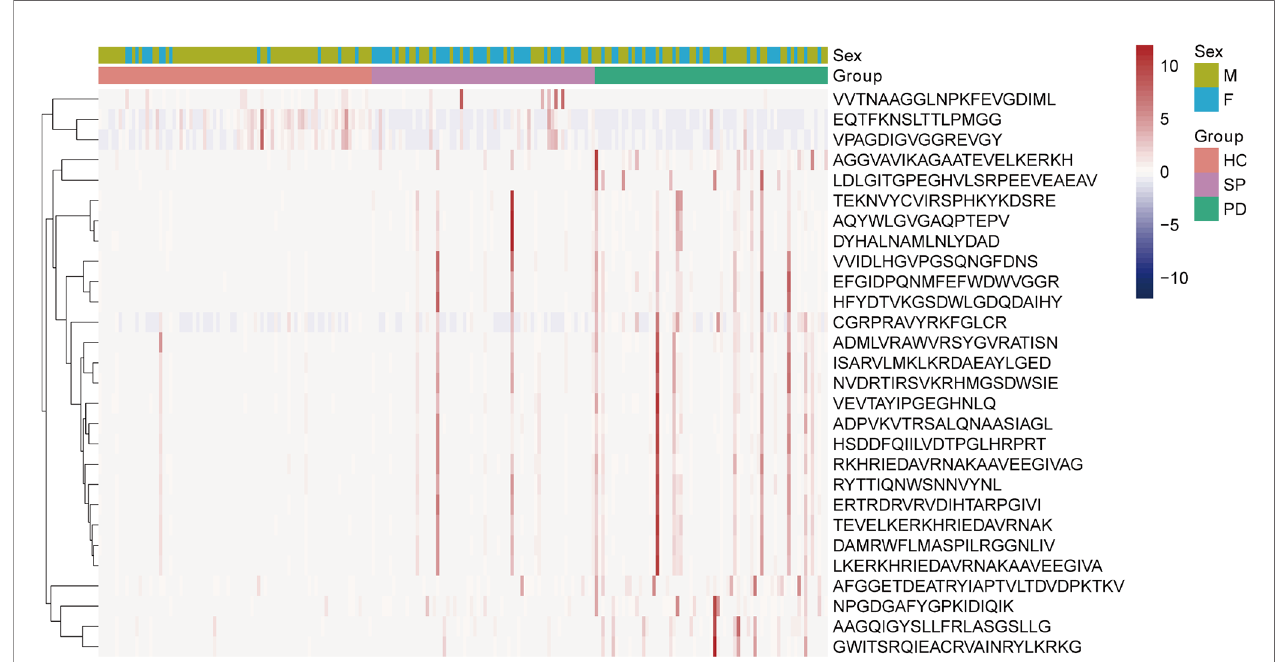
FIGURE 4 | Analysis of gut microbiota-associated epitopes in PD patients and control subjects. Heatmap of signi fi cantly different epitope biomarkers in samples from PD group (Green), HC group (pink), SP group (purple). In the bar, pink and blue indicate high and low abundance,